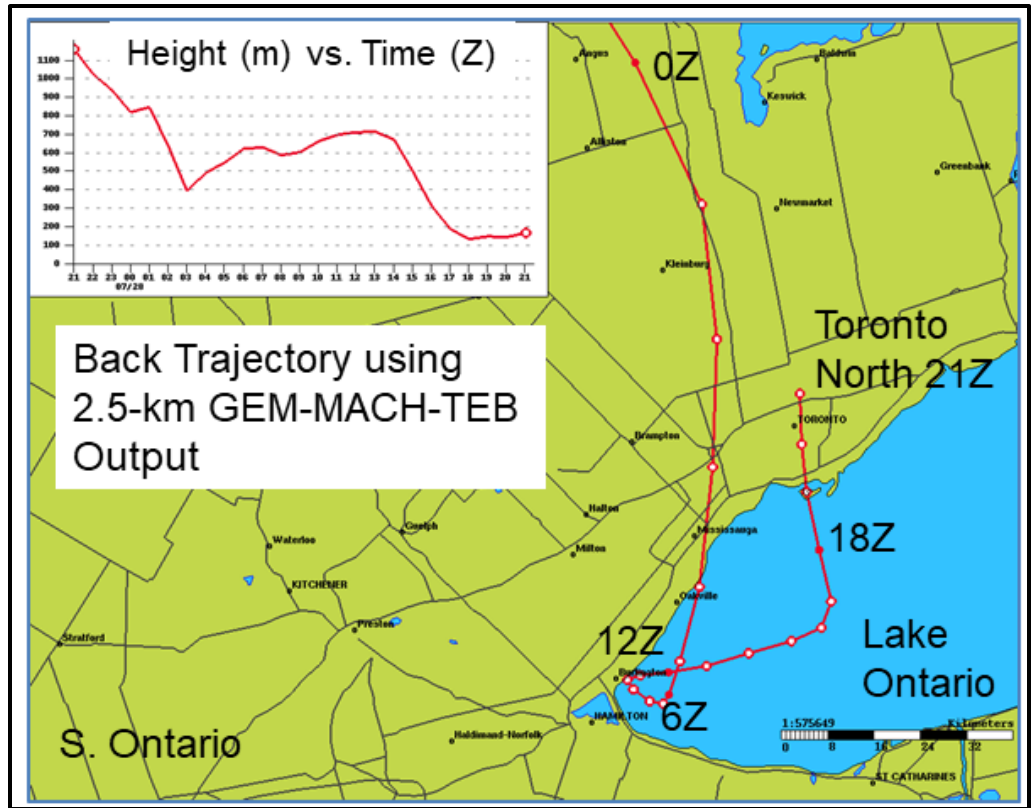
Figure 15. Air-mass back trajectory ending at North Toronto station at 175-m agl at 21:00 UTC 28 July 2015. The trajectory was calculated using the 2.5-km GEM-MACH-TEB wind output.